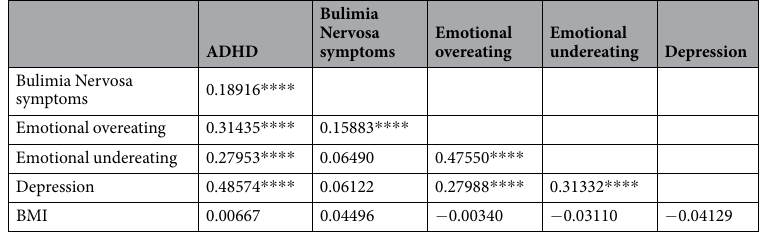
Table 3. The partial correlation among variables controlling for gender. **** P < 0.0001 .